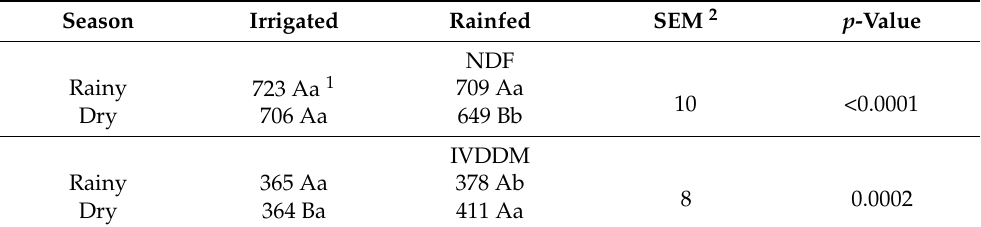
Table 7. Stem neutral detergent fiber (NDF) and in vitro digestible dry matter (IVDDM) (g/kg dry matter), as affected by the interaction between irrigation and season for elephantgrass genotypes at Garanhuns, Pernambuco, Brazil.